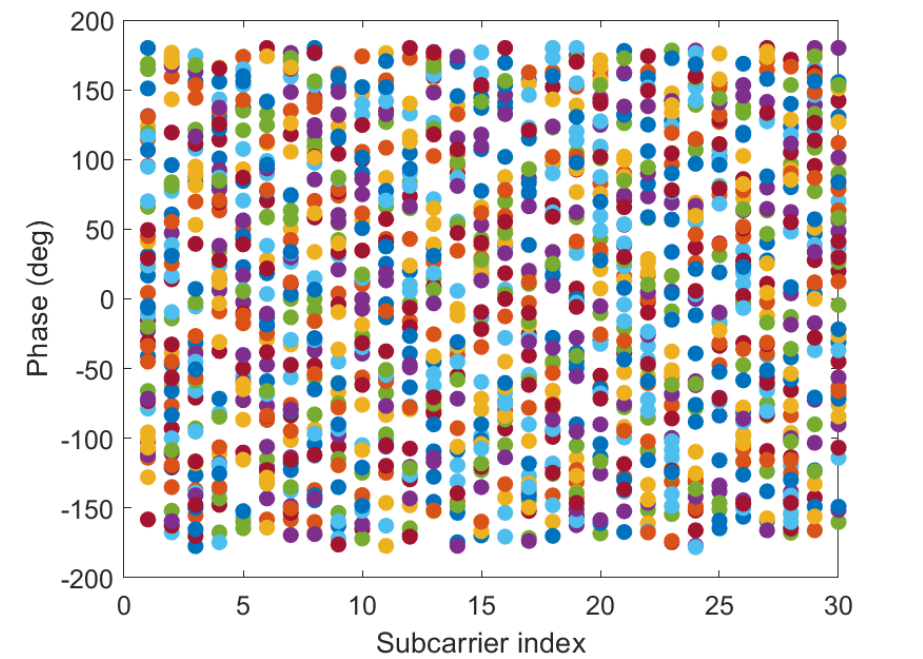
Figure 13. The phases of the 30 CSI sub-carriers on antenna a at reference point (0,1) of AP1 in the lobby of IT2